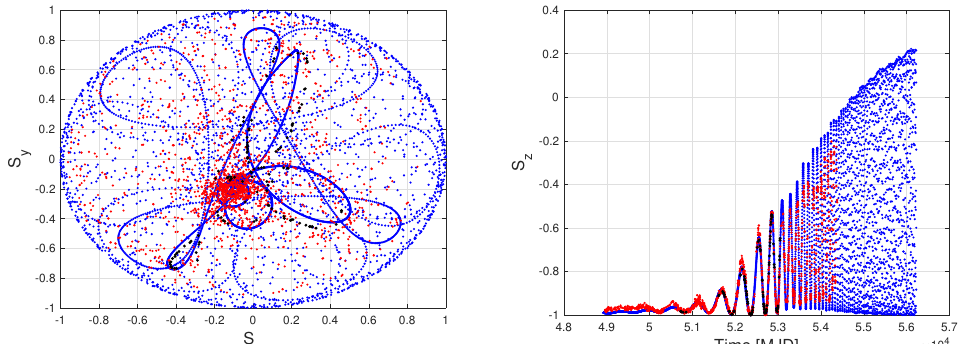
Figure 2. Spin evolution of LAGEOS II on the basis of the LASSOS model (blue dots), compared with observations (red and black). Left: Projection of the satellite spin direction on the equatorial plane ( S x , S y ). Right: Time evolution of the satellite spin direction along the vertical axis ( S z ). Both projections are in the J2000 reference frame, time is expressed in Modified Julian Date (MJD).